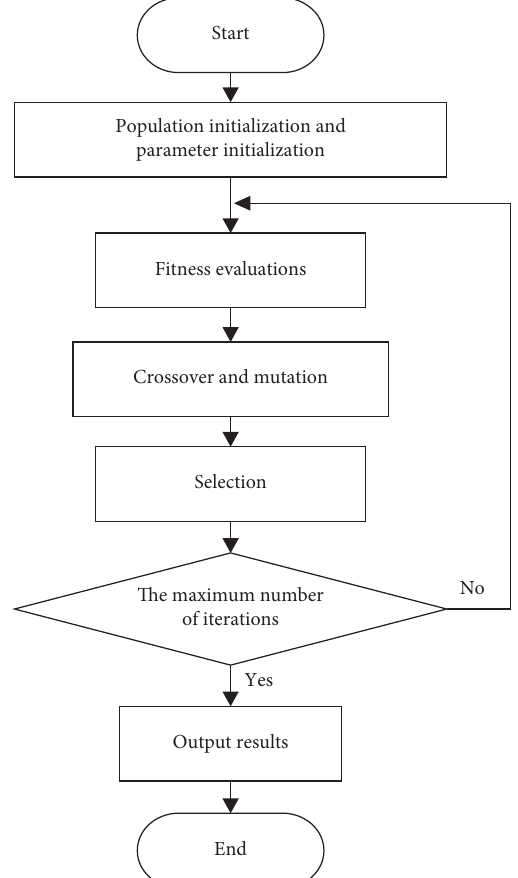
Figure 7: Flowchart for the genetic